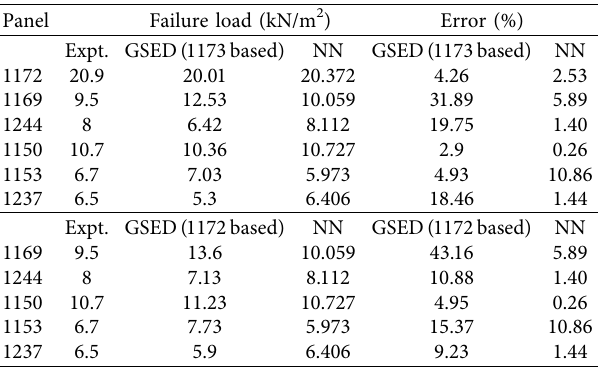
Figure 6: Comparison of (a) the NN and (b) FEA prediction with the experimental failure load. The x � y line represents the ideal state when predicted results are equal to the experimental failure load. Table 7: Comparison between proposed NN and GSED methods (two panels (1173 and 1172) are used in the GSED method as the base on which the prediction is